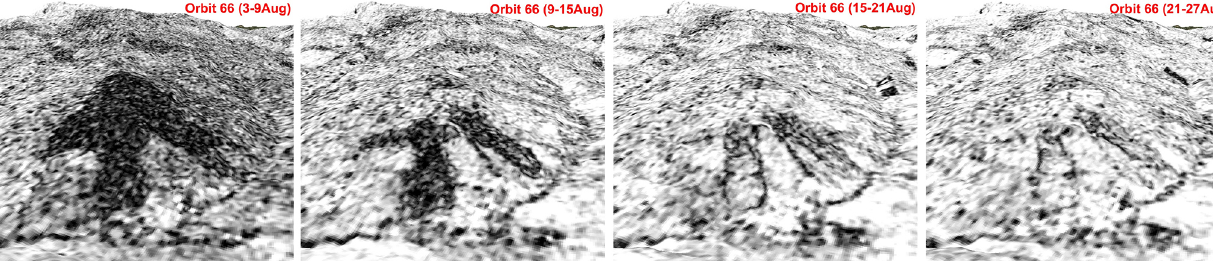
Figure 12. The 3D view of Kherba landslide, Sentinel-1 coherence images of orbit 66 with a 6d temporal baseline; the dark areas are the landslide and deformation